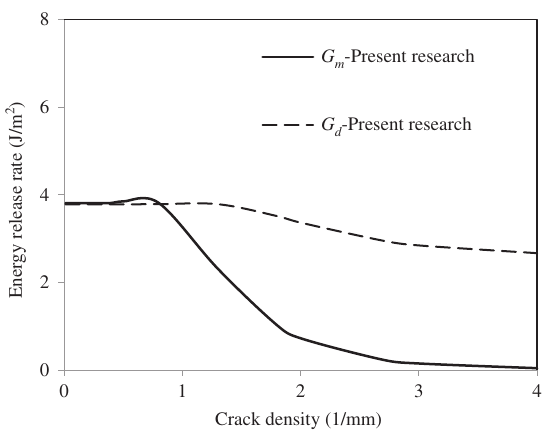
Figure 12: Crack density vs. energy release rate for [45/−45] s carbon/ epoxy laminate under σ